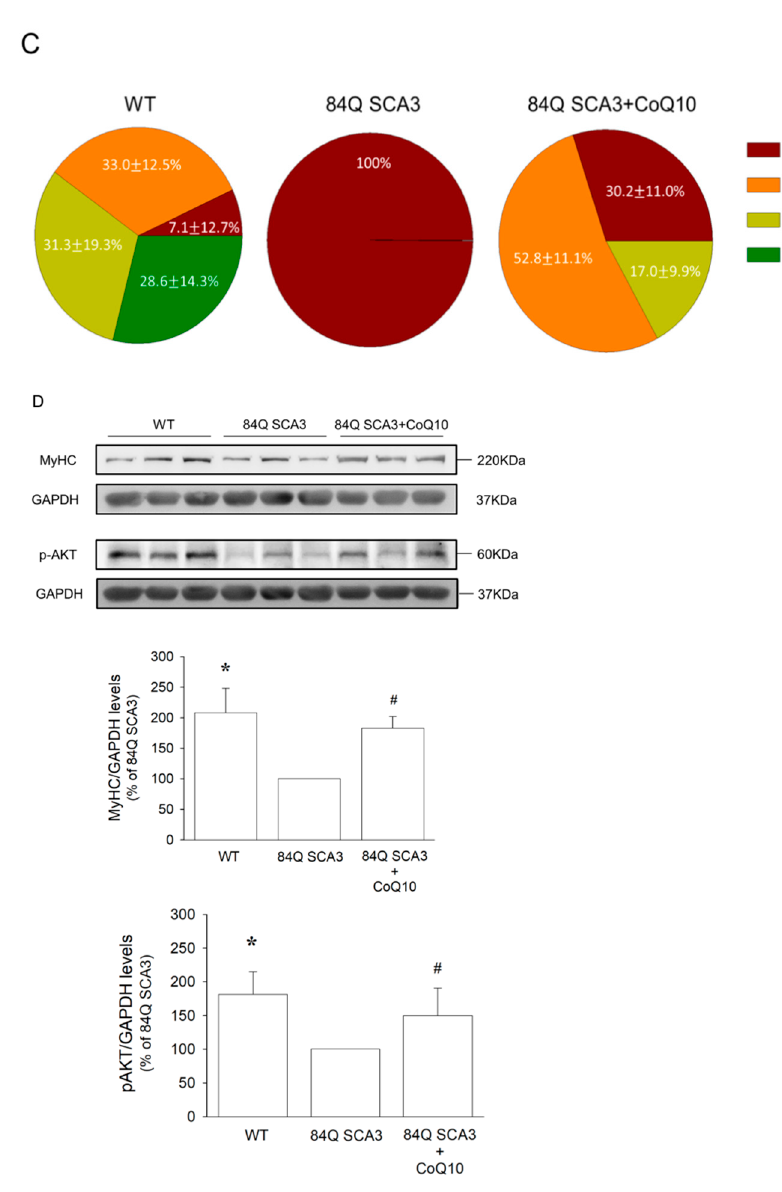
Figure 6. Effects of CoQ10 on muscle atrophy in the TA and GA muscles of 84Q SCA3 mice. At the age of 16 months, ( A ) graphs representing the H&E staining of TA muscle sections. ( B ) CSA of TA muscle fibers. ( C ) Pie charts representing the percentage with number of TA muscle fibers of CSA distribution: 0–1500, 1500–2000, 2000–2500, >2500 µ m 2 . ( D ) The expression of MyHC and phosphorylated AKT in GA muscles normalized against an internal control (GAPDH) with the same amount of loading protein and the quantification shown as the down panel. In panels D, values from treated mice were normalized to those of the 84Q SCA3 group. Data are presented as the mean ± SD. * p < 0.05 indicates the WT group compared to the 84Q SCA3 group. # p < 0.05 indicates the 84Q SCA3 + CoQ10 group compared to the 84Q SCA3 group. + p < 0.05 indicates the 84Q SCA3 + CoQ10 group compared to the WT group. CSA, cross-sectional area; GA, gastrocnemius muscle; TA, tibialis muscle; WT, wild-type controls; 84Q SCA3, chow diet of vehicle; 84Q SCA3 + CoQ10, CoQ10